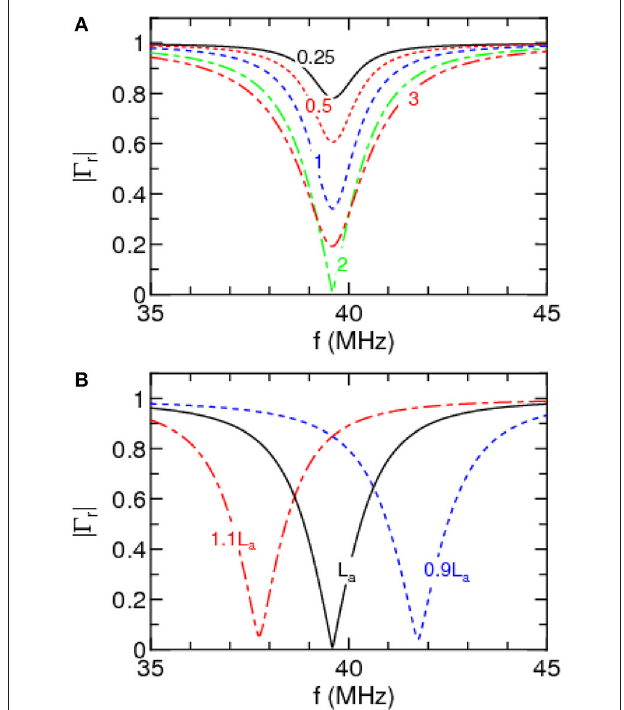
FIGURE 4 | (A) Reflection coefficient | Γ r | calculated by Equation (5) as a function of the frequency for various values of the resistance R , where C 1 390 pF, C 2 73 pF, and the antenna inductance L a = Equation (6) are used for the calculation. (B) Reflection coefficient for R when changing the antenna inductance by